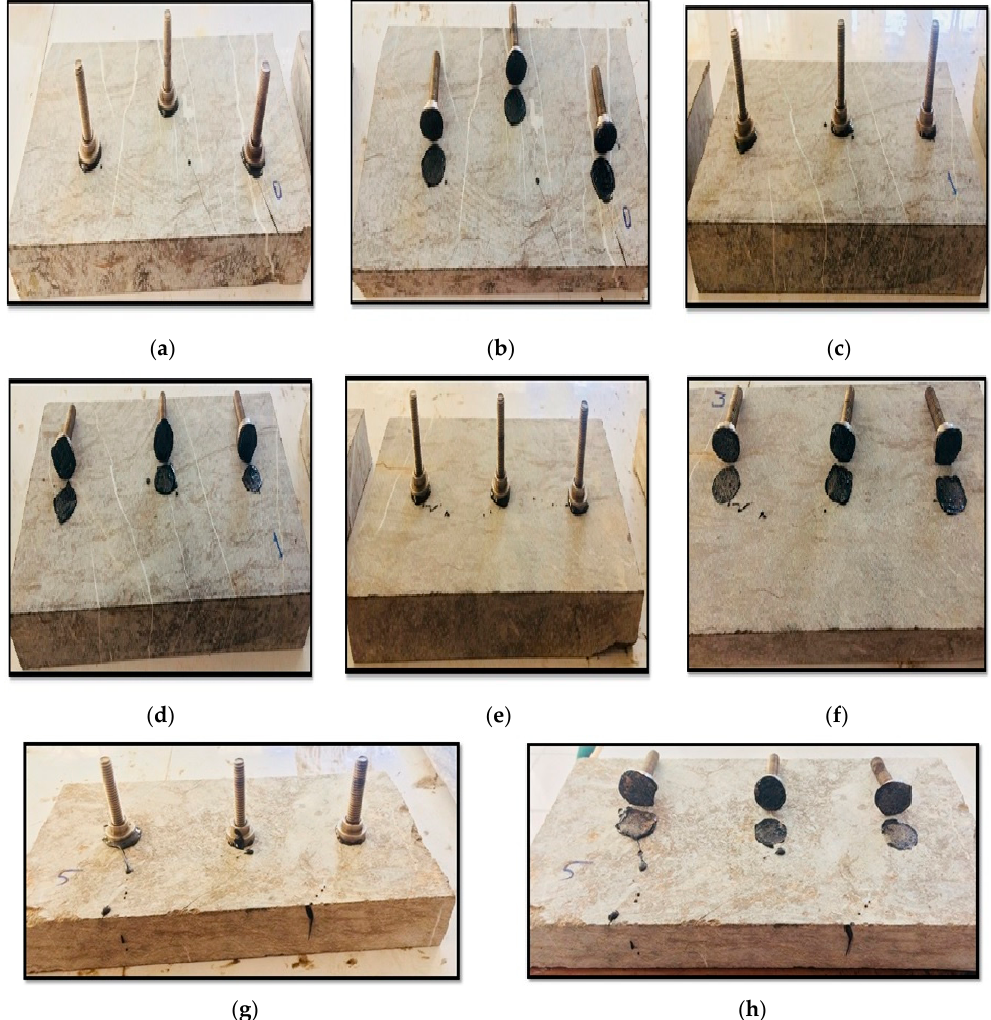
Figure 16. ( a , c , e , g ) 0%, 1%, 3%, and 5% QNPs, respectively, before burst; ( b , d , f , h ) 0%, 1%, 3%, and 5% QNPs, respectively, after burst.